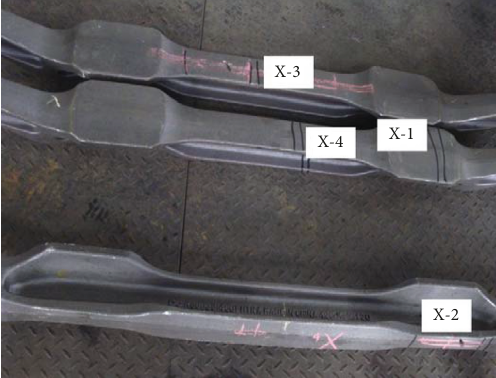
Figure 2: The front axle components of Steel A.